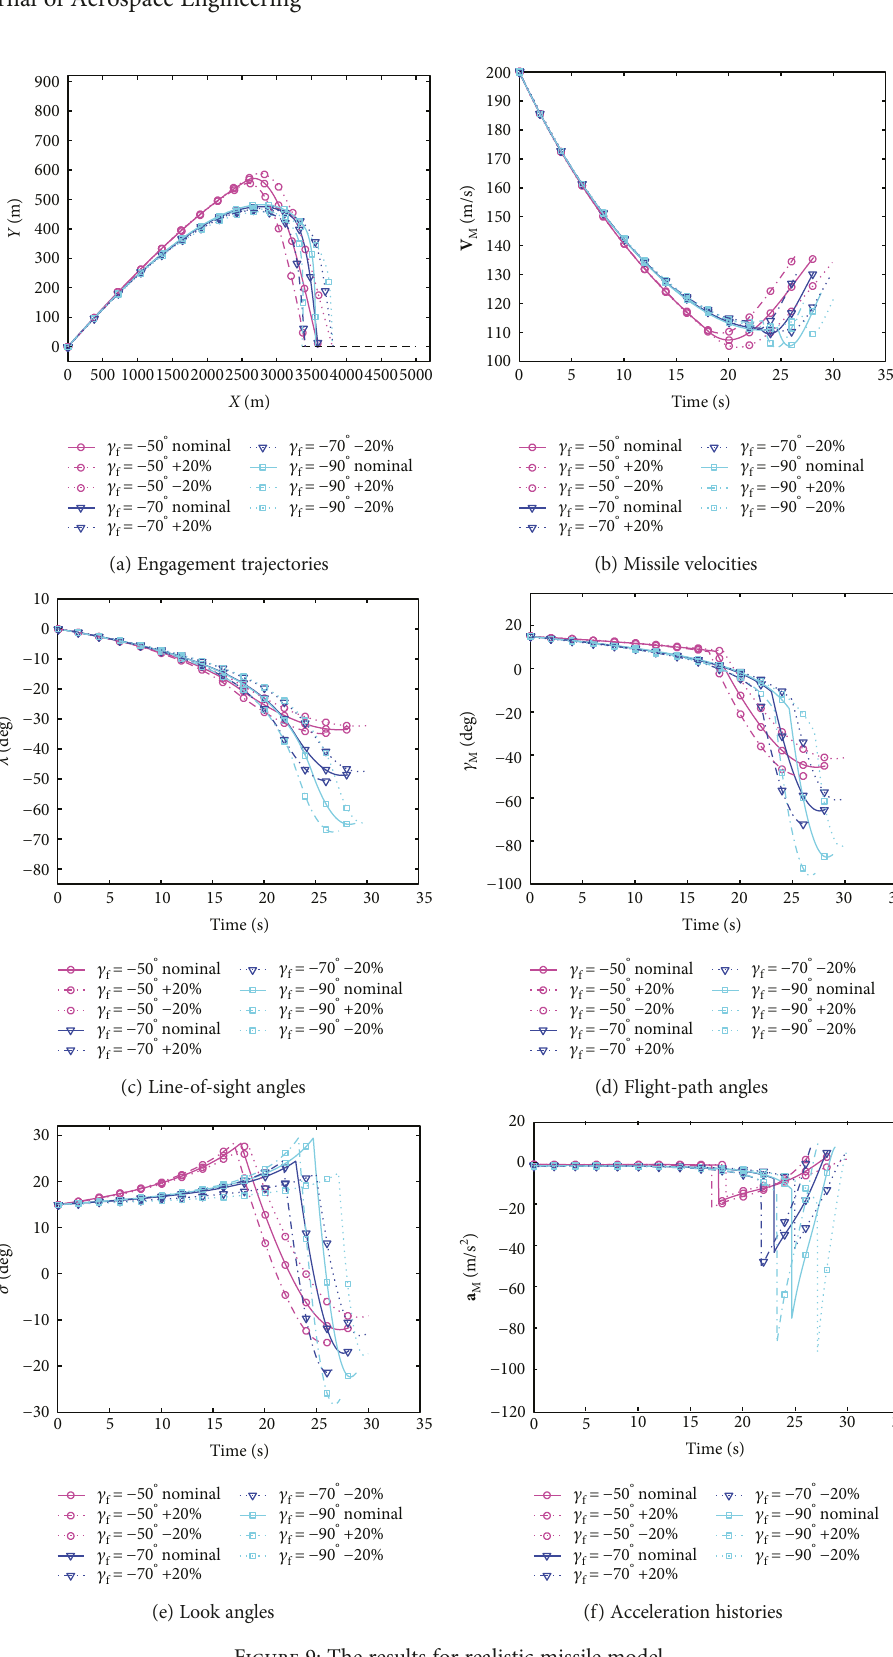
Figure 9: The results for realistic missile